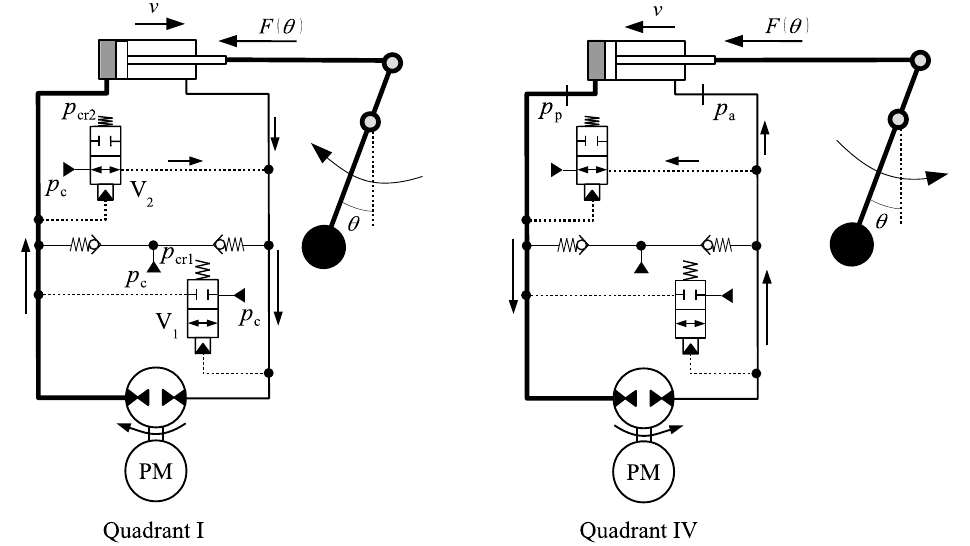
Figure 19. Circuit with two 2 × 2 compensation valves and external force on the cylinder rod (first and fourth quadrants).